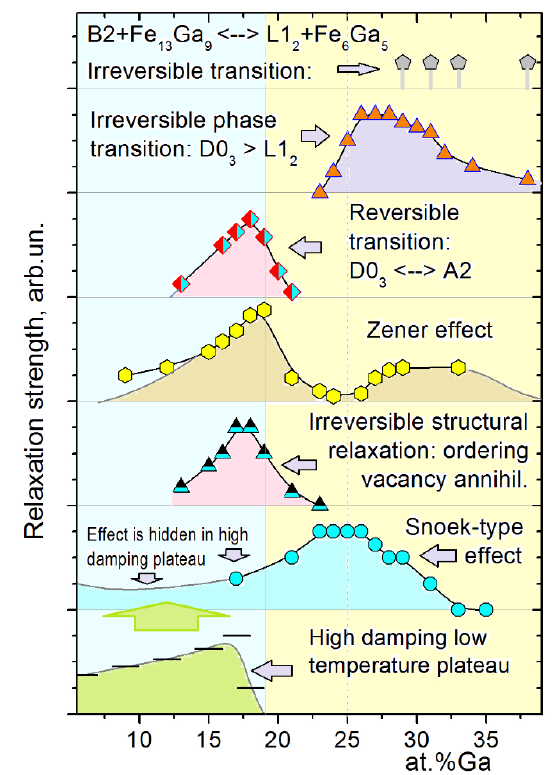
Figure 29. Scheme of different effects at temperature-dependent internal friction curves for rapidly cooled (water- or air-quenched and as-cast) Fe–(6–38)Ga: from bottom to the top—high-damping low-temperature plateau, Snoek-type thermally activated effect, first transient irreversible effect due to structural relaxation, Zener thermally activated peak, reversible transient effect due to the order–disorder transition, irreversible transient effect due to D0 3 to L1 2 phase transition, irreversible transient effect due to D0 3 + Fe 13 Ga 9 to L1 2 + Fe 6 Ga 5 phase transition. Values for relaxation strength for all effects are given in arbitrary units; they are supposed to provide qualitative but not quantitative dependencies. Light blue background underlines Fe–Ga alloys without first-order phase transition, while the light yellow background corresponds to the alloys with different first-order transitions. Vertical grey dotted line corresponds to the Fe 3 Ga composition.